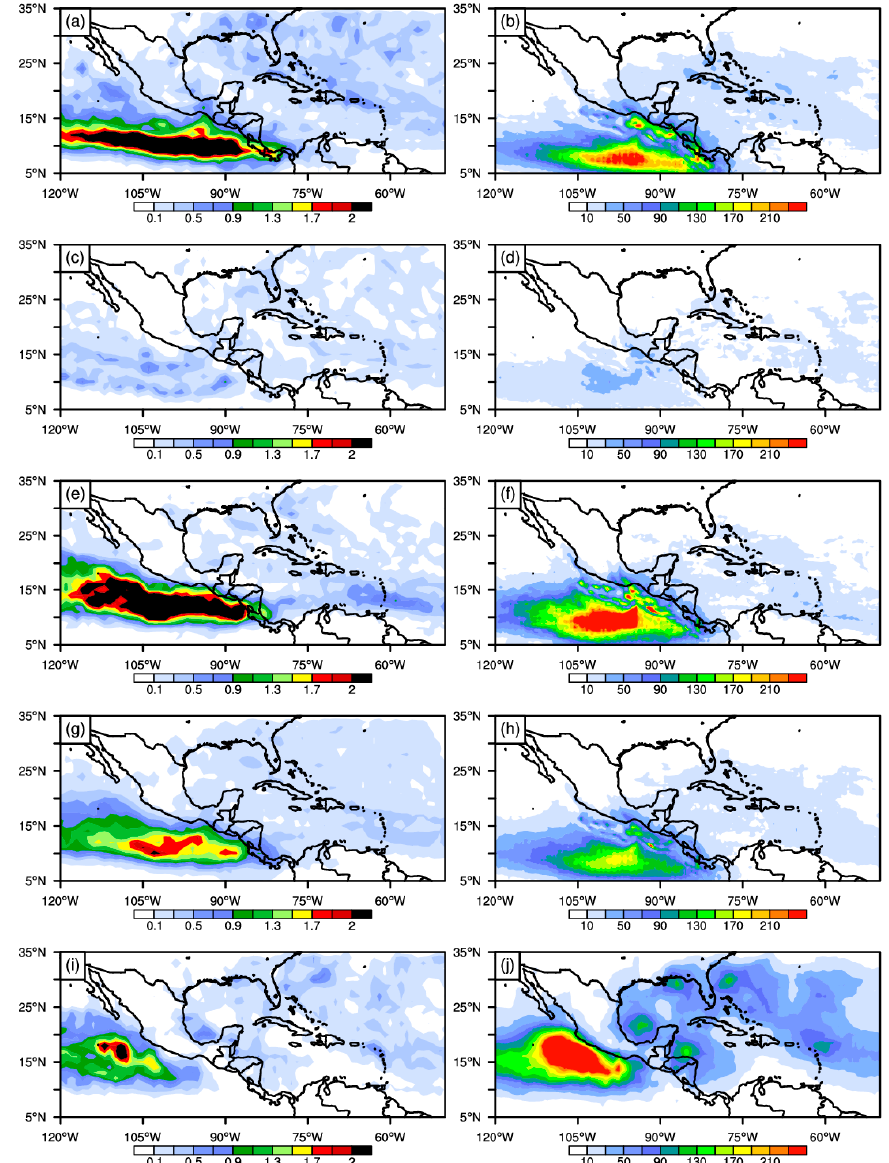
Figure 4. Mean annual tropical cyclone density for three members of the RCM ensemble: ( a ) rktm, ( c ) rnty, ( e ) rtty, ( g ) ensemble mean, ( i ) HURDAT, and mean annual tropical cyclone rainfall for three members of the RCM ensemble: ( b ) rktm, ( d ) rnty, ( f ) rtty, ( h ) ensemble mean, and ( j ) ERAI during the 1990–2000 period.